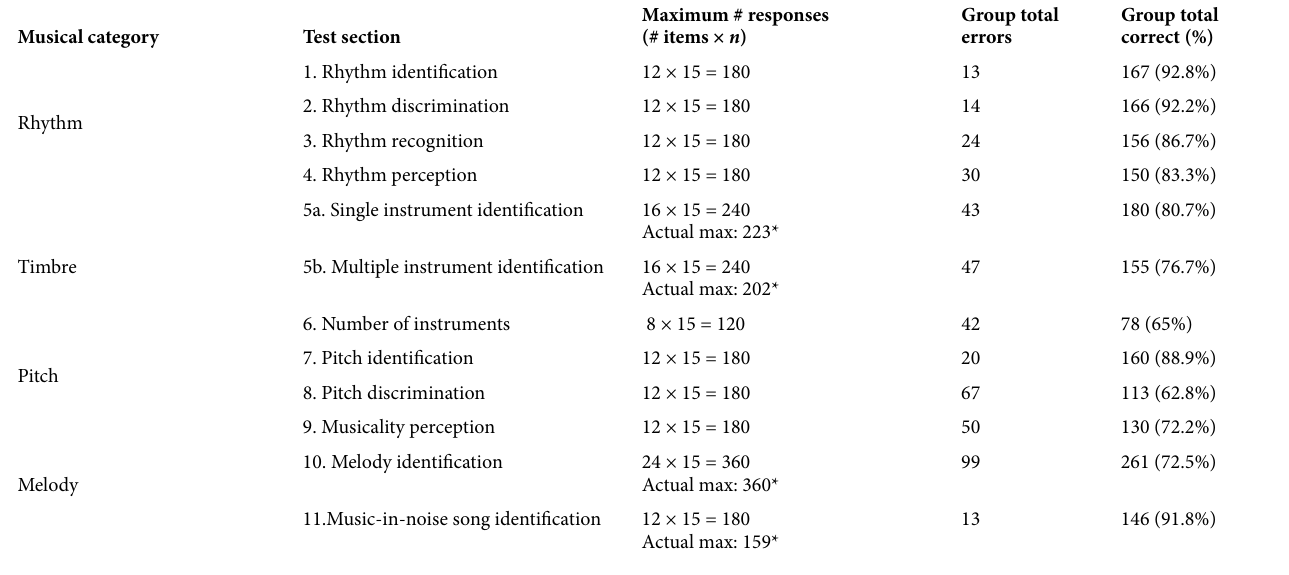
Table V. Error rates and percentage correct for the first version of the MPT presented to normal hearing par- ticipants ( n =15) Musical